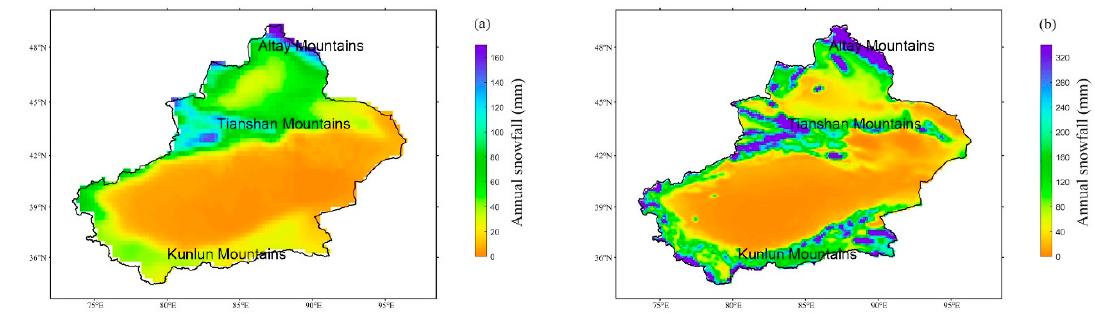
Figure 2. Spatial distributions of climatology snowfall during the cold season (mm). ( a ) is CN05.1, ( b ) is WRF.